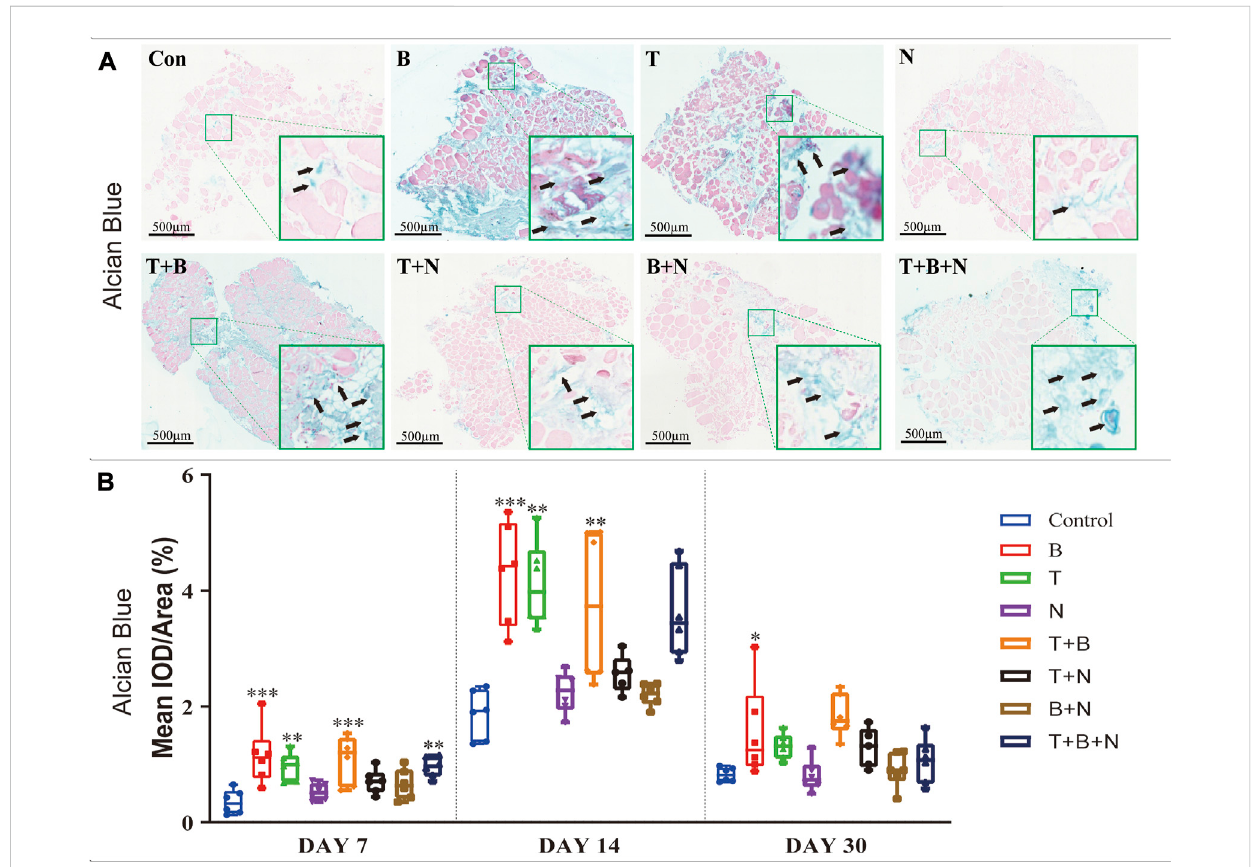
FIGURE 2 The staining results of Alcian Blue in each group. (A) Staining results on day 30; the positive staining color was blue (marked by black arrows). (B) Histomorphometrical assessment; the result was shown as Mean IOD/Area. Control group vs. stimulated groups at 7, 14, and 30 days; the asterisks indicatethatthestimulatedgroupisstatisticallysigni fi cantcomparedtothecontrolgroup.(Magni fi cation:×40;n=6;* p < 0.05;** p < 0.01;*** p <